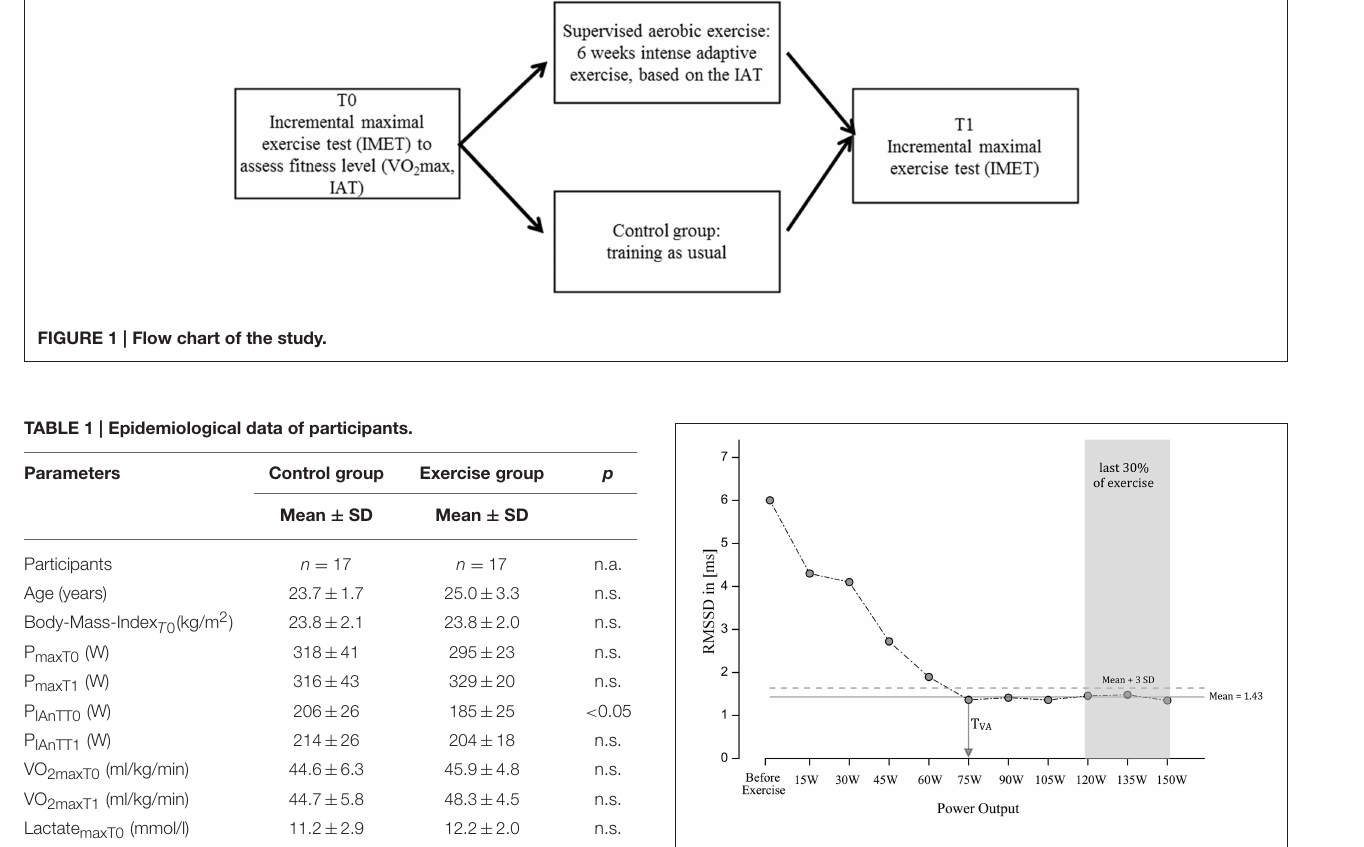
FIGURE 2 | The calculation of the vagal threshold is depicted using data from one subject for illustration. The deflection point is the point in time at which no subsequent decline in heart rate variability occurs. DP was determined when the heart rate variability dropped below a threshold (mean value of the heart rate variability plus 3 times the standard deviation during the last 30% of the “exercise time”). In this time period, the decline in heart rate variability was completed and there were almost no variations in heart rate variability